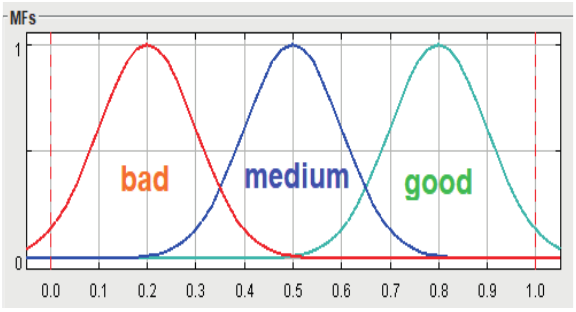
Fig. 3. Membership function for routing variable.